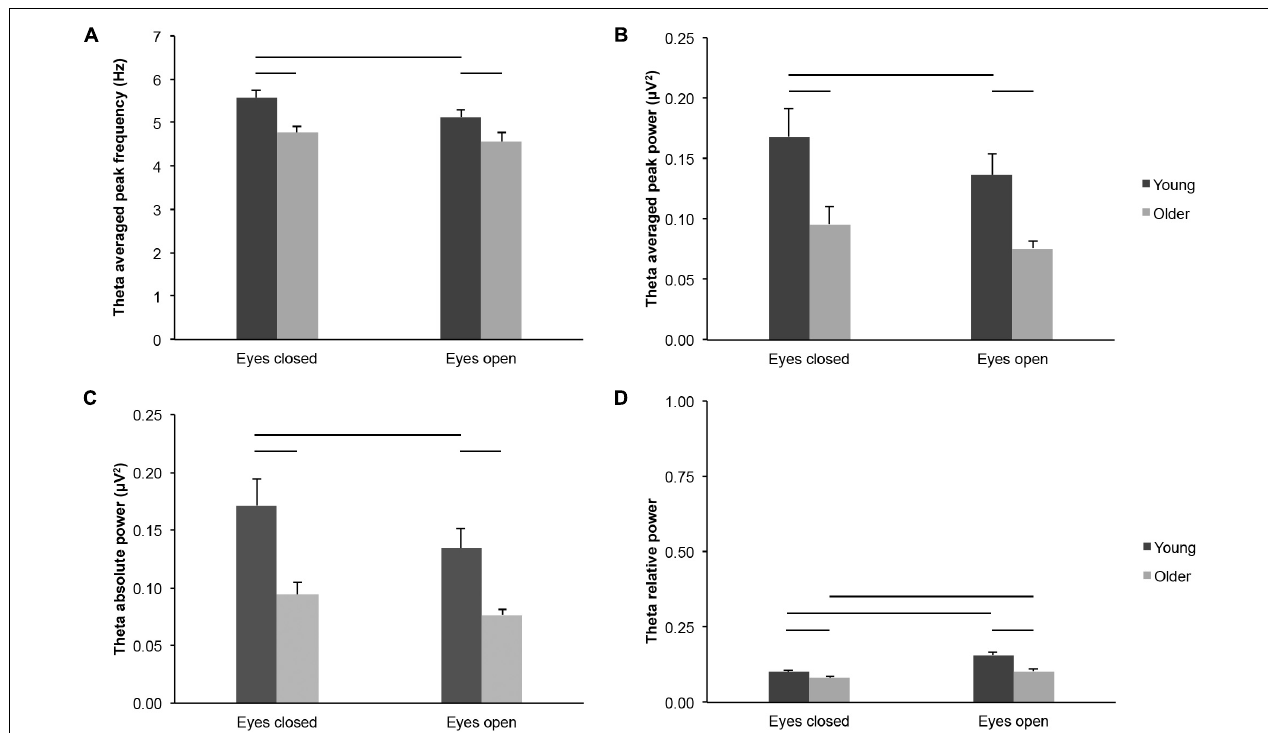
FIGURE 2 | Theta-band activity measured across the scalp in healthy 20–30-year-old (Young; dark gray bars) and 65–75-year-old (Older; light gray bars) adults. (A) Theta averaged peak frequency. (B) Theta averaged peak power. (C) Theta absolute power. (D) Theta relative power. Average ± SEM. Horizontal bars indicate statistically significant differences between age groups or eye conditions ( p <